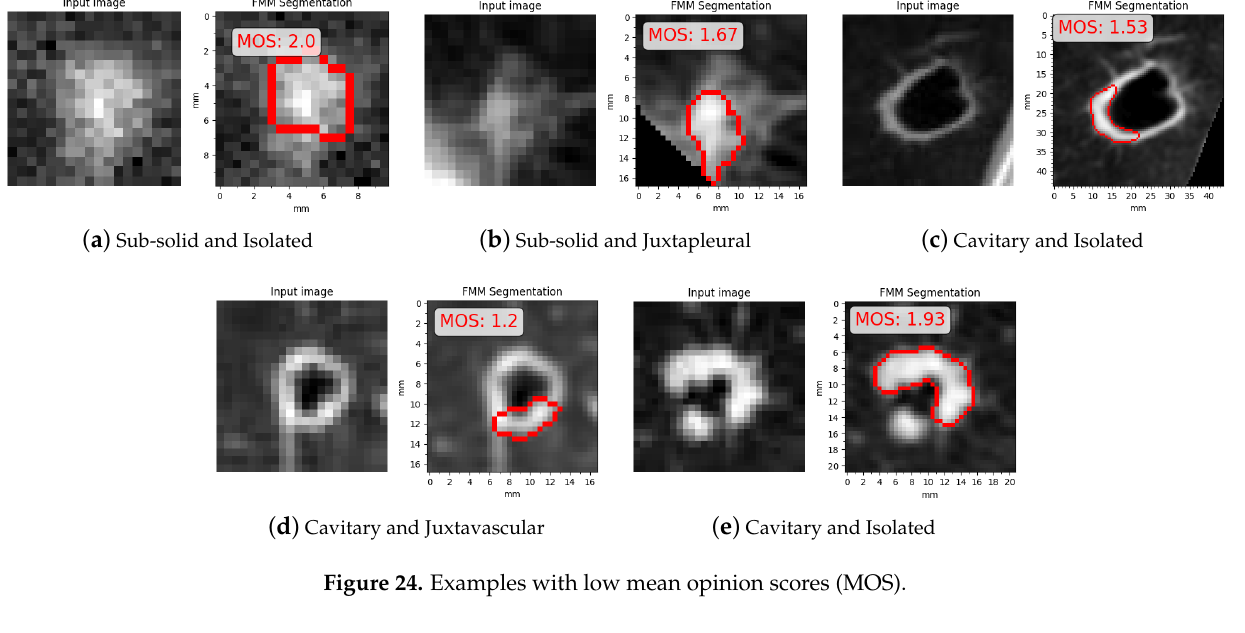
Figure 24. Examples with low mean opinion scores